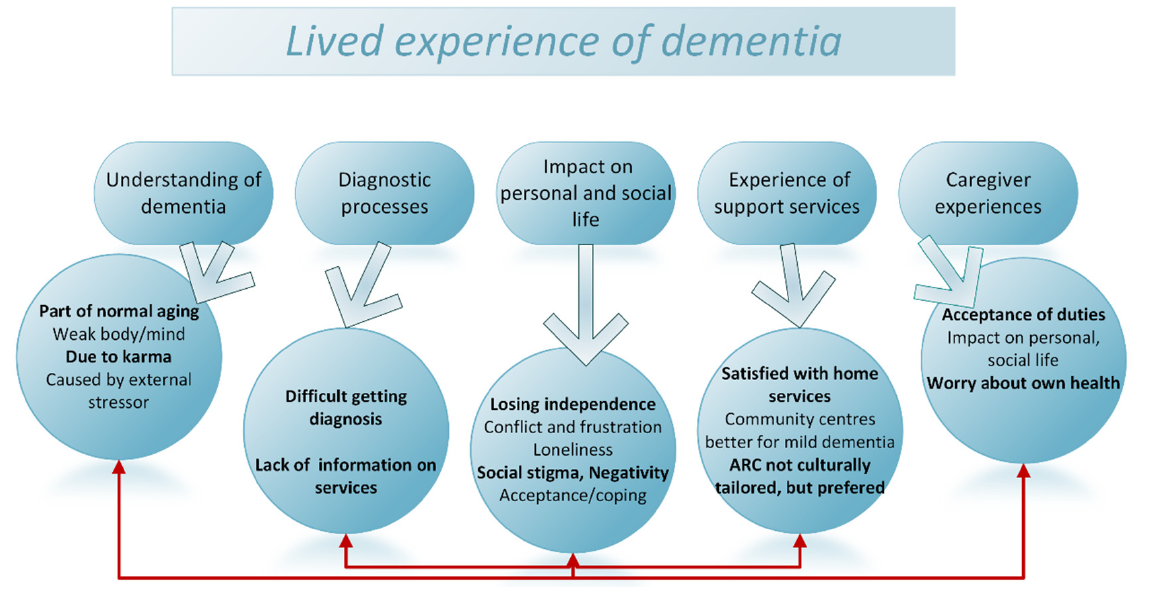
Figure 1. Summary of identified themes and subthemes. ARC: aged residential care